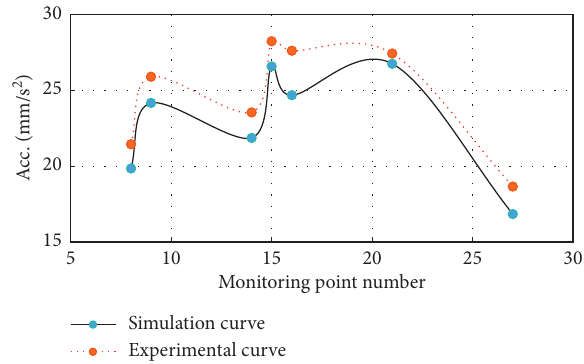
Figure 13: Peak acceleration at each measured